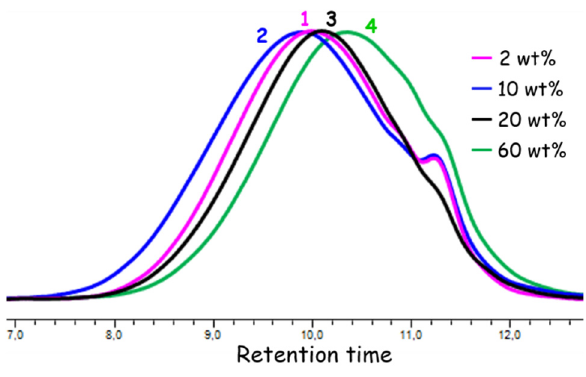
Figure 3. GPC curves obtained in Experiments 1 – 4. Table 1. Experimental data on the effect of monomer concentration, reaction time, and temperature.